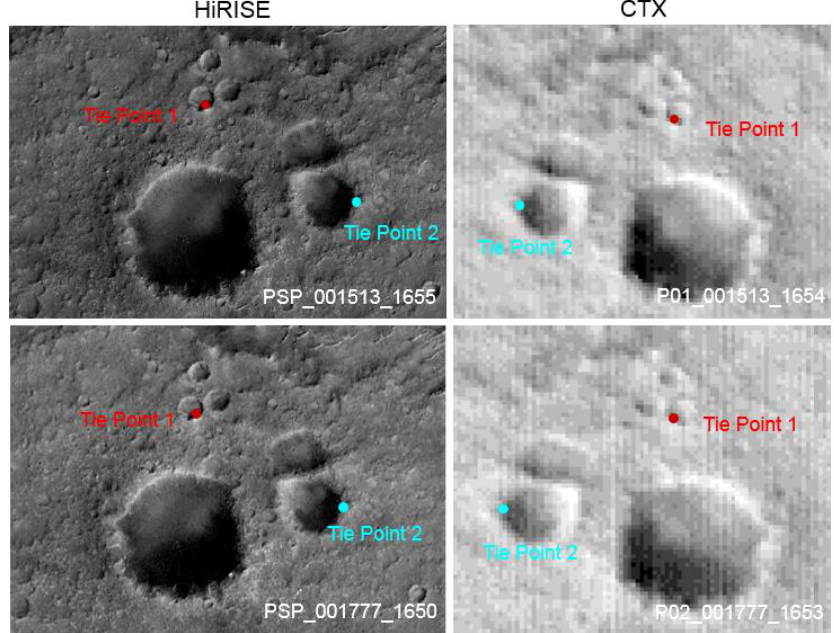
Figure 4. Examples of identifying tie points in the HiRISE and CTX stereo